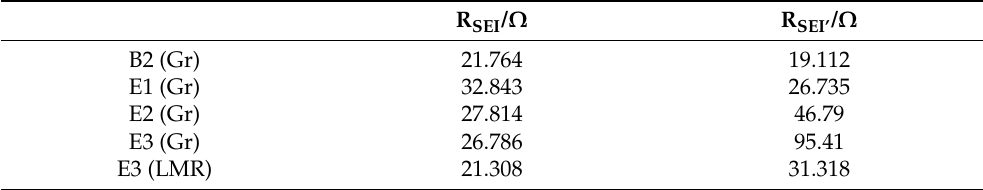
Figure 5. EIS analyses of C||Li batteries before ( a ) and after ( b ) 3 CV cycles. ( c ) EIS analysis of LMR||Li battery. Table 2. EIS data of graphite (Gr) anodes and LMR cathodes before (R SEI ) and after (R SEI’ ) 3 CV